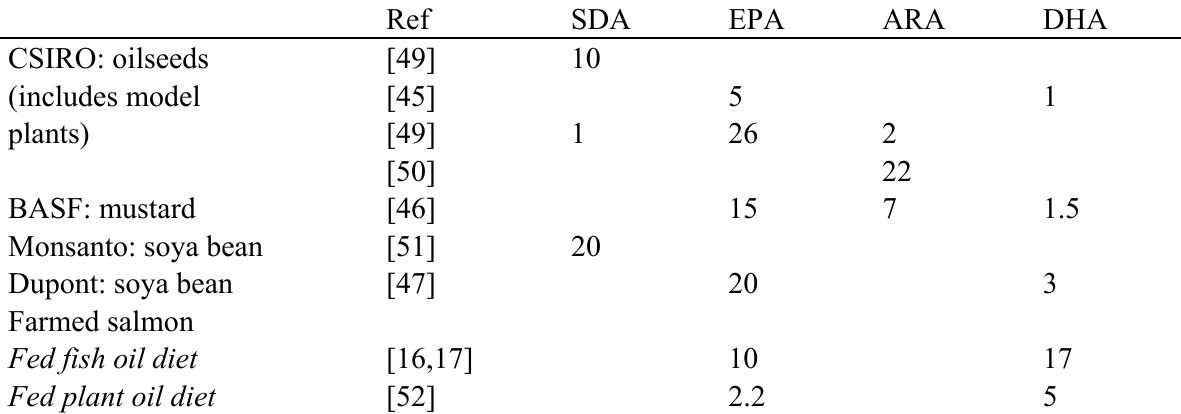
Table 4. Comparison of fatty acid composition (expressed as g/100 g of total fatty acids) for new land plants containing the C omega-3 PUFA stearidonic acid, arachidonic acid or 18 LC omega-3